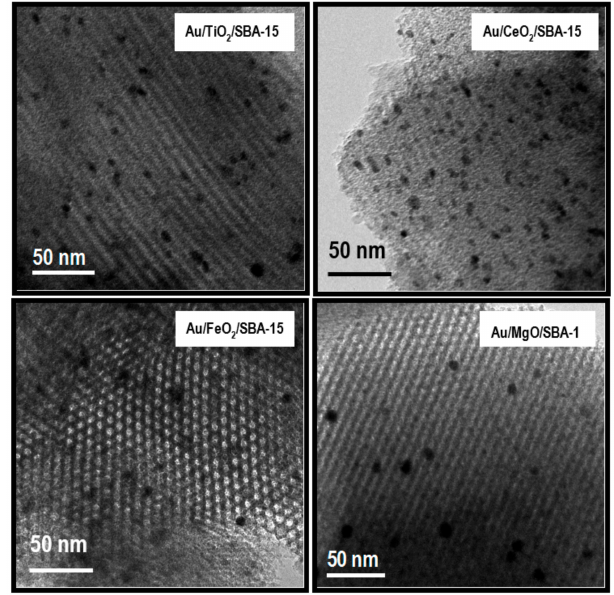
Figure 2. TEM micrographs showing parallel fringes (side-on view) of the calcined Au/TiO 2 /SBA-15 and Au/CeO 2 /SBA-15 samples, and hexagonal array (viewed along the pore direction) of the calcined Au/Fe 2 O 3 /SBA-15 and Au/MgO/SBA-15 catalysts.